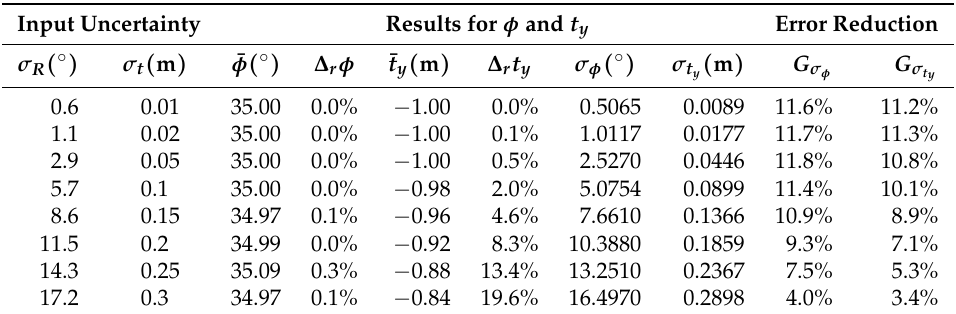
Table 5. Summary of uncertainty propagation when using 3 paths with Gaussian PDF for input uncertainties. The last two columns in the table show the gains in error reduction by using the multi pairwise approach. The results are poorer than those shown in Table